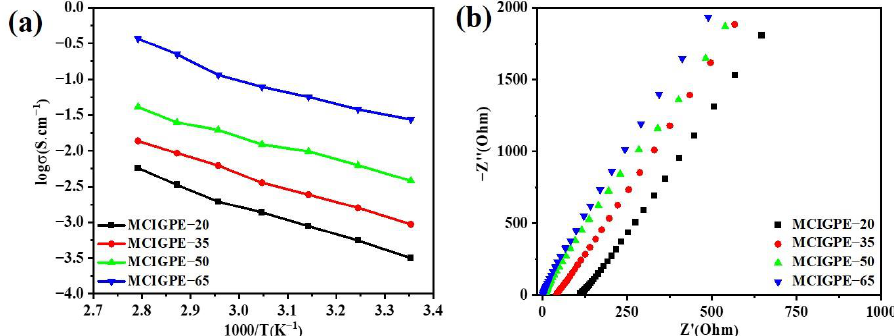
Figure 4. ( a ) The ionic conductivity of the ionic gel polymer electrolytes containing 20%~65% ionic liquids in the temperature range from 25 °C to 85 °C, ( b ) impedance spectra of the ionic gel polymer electrolytes at 35 °C.